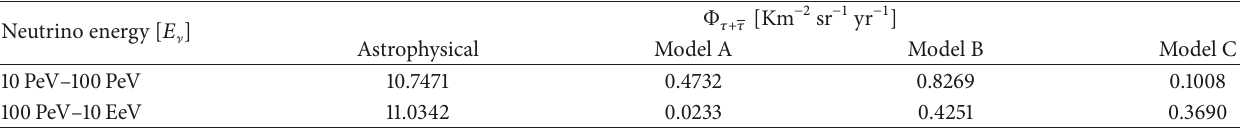
Table 4: Tau charged lepton fluxes ( Φ 𝜏+𝜏 ) produced by neutrino-nucleon interactions in “standard rock” with average width 𝐴 . The astrophysical flux is obtained from the extrapolation of the measured neutrino flux by IceCube. See the text for details. Neutrino energy [ 𝐸 ] ]